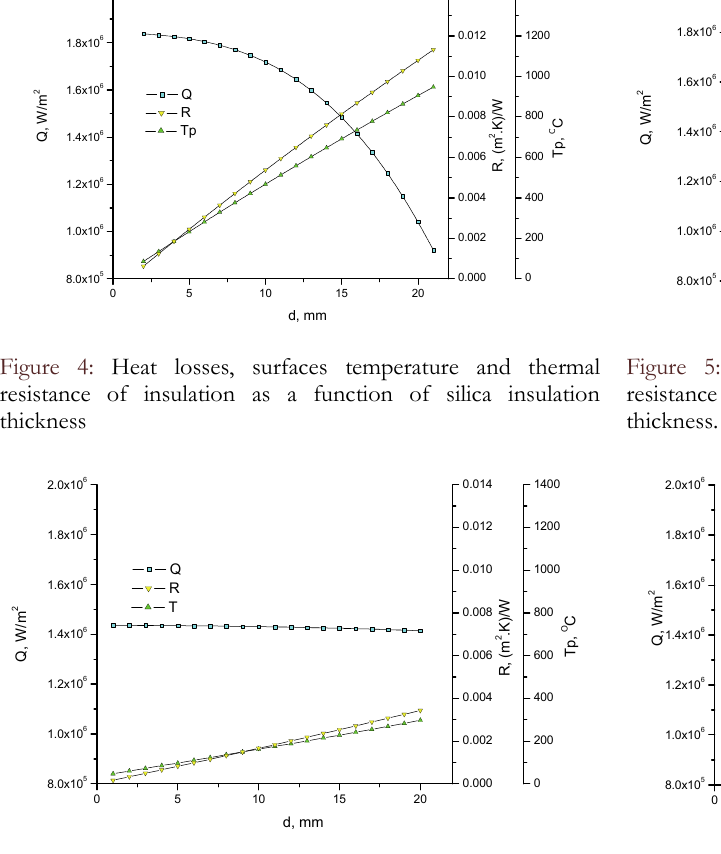
Figure 7: Heat losses, surfaces temperature and thermal resistance of insulation as a function of shamote insulation